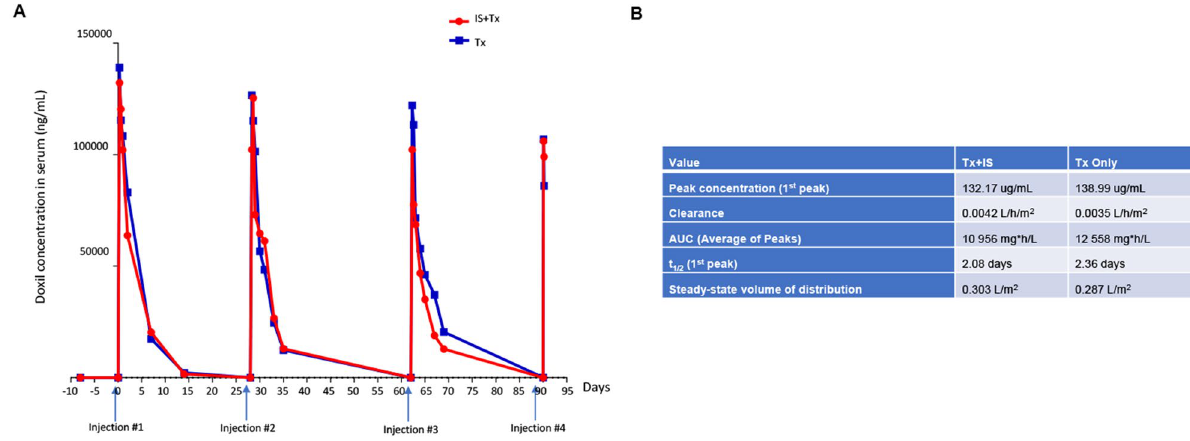
Figure 6. Pharmacokinetics of Doxil in cynomolgus monkeys. Doxil was detected in serum using anti- PEG antibodies and a HRP-conjugated secondary antibody. ( A ) Pharmacokinetics after each cycle. ( B ) Pharmacokinetics parameters after the first cycle.